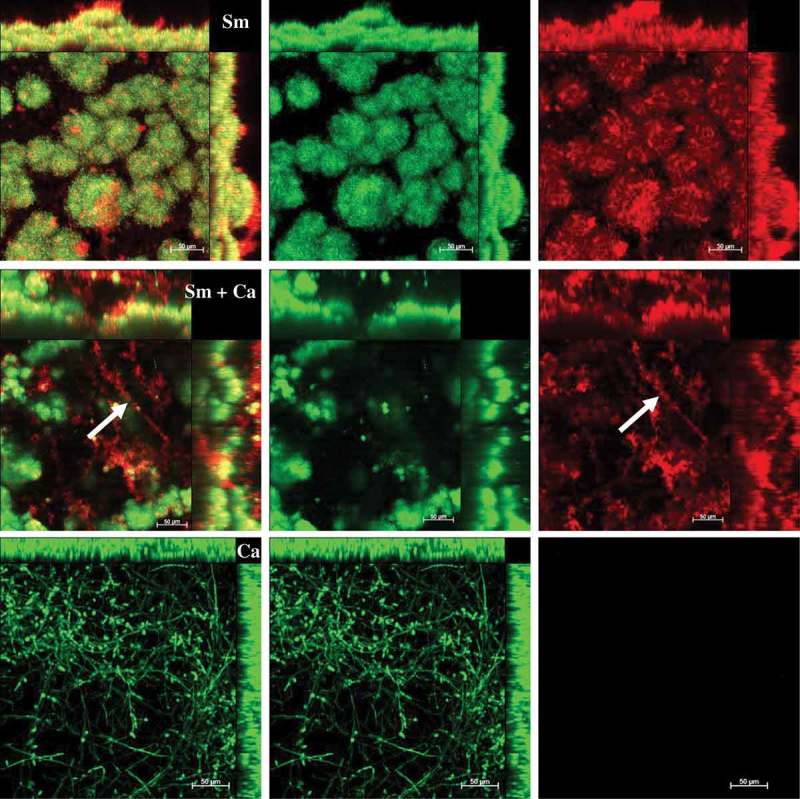
Representative confocal microscopy images of 43 h-old S. mutans and C. albicans dual- and single-species biofilm. The green color represents the microbial content in each biofilm (labeled with SYTO9), while the red color represents ESP in the extracellular matrix produced by S. mutans Gtfs (labeled with Alexa Fluor 647). The images in the first column show the overlay of both components, while the second and third images illustrate each component individually. The white arrow shows hyphae of C. albicans surrounded by exopolysaccharides produced by S. mutans. Sm: S. mutans and Ca: C. albicans.